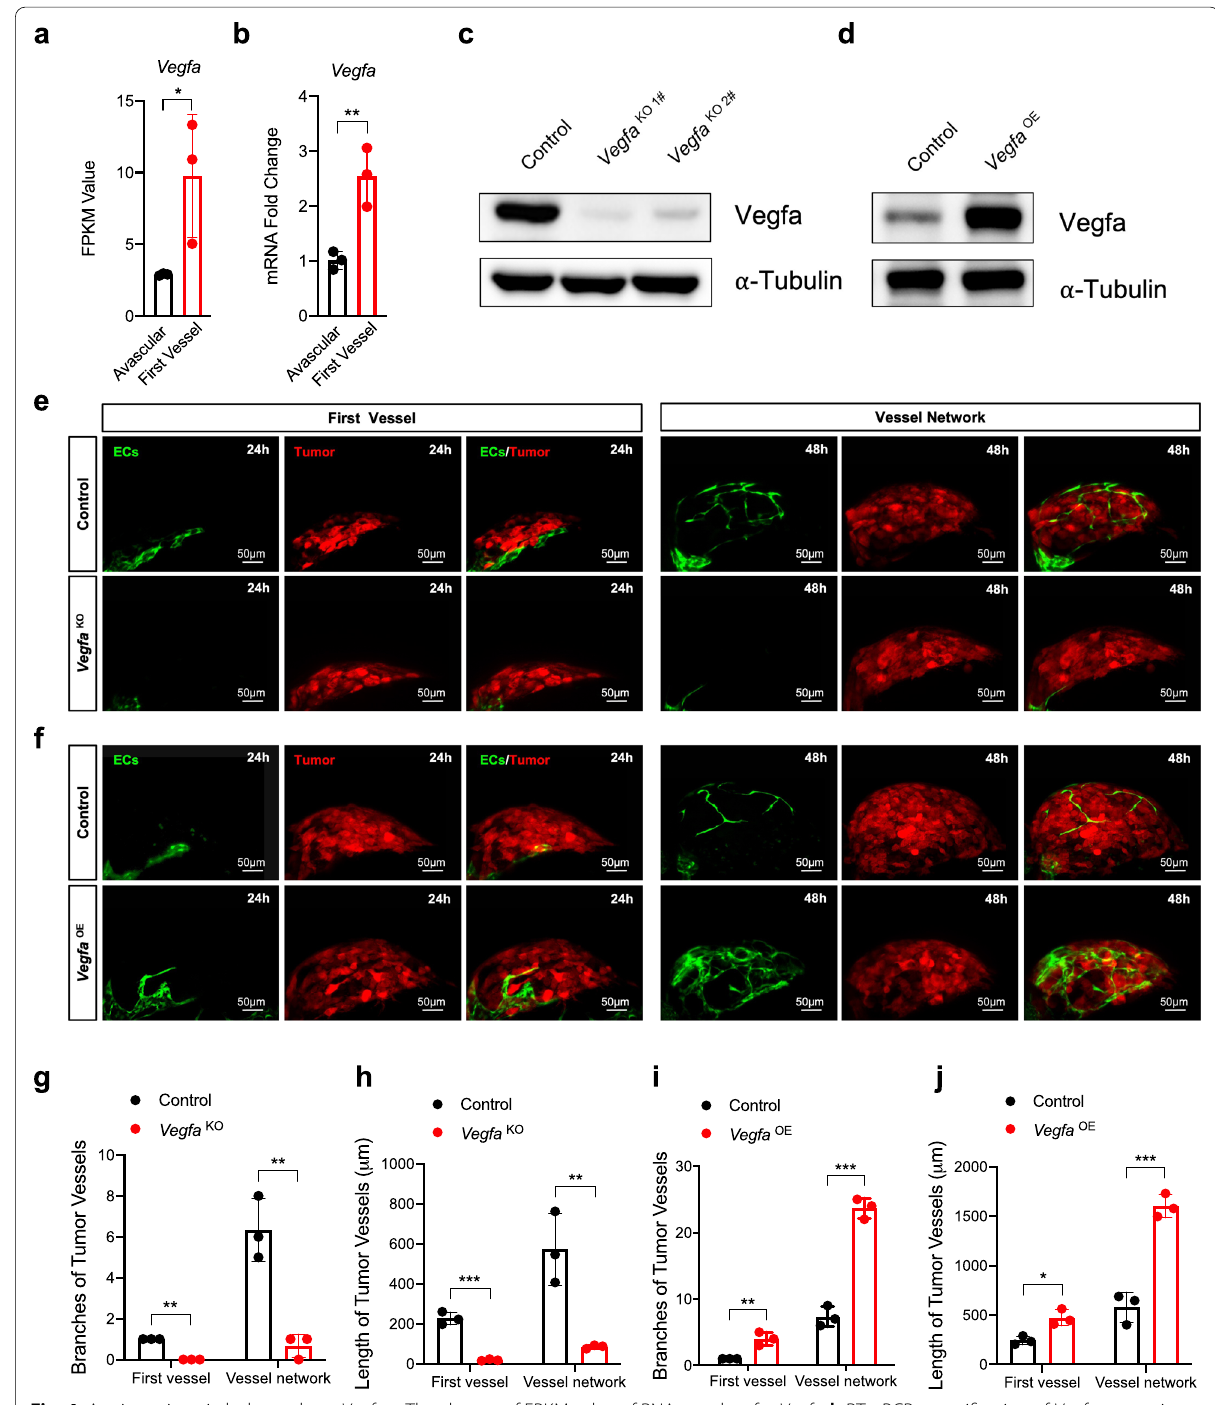
Fig. 4 Angiogenic switch depends on Vegfa . a The change of FPKM value of RNA-seq data for Vegfa . b RT-qPCR quantification of Vegfa expression in the transplant microtumors during the angiogenic switch (about 12 h and 24 h). c and d Western blot analysis of Vegfa and α-tubulin of B16-Red cells transfected with LentiCRISPRv2- Vegfa , sg1# ( Vegfa KO 1# ) or sg2# ( Vegfa KO 1# ) knockout plasmid or pcDNA3.1-VEGFA overexpression plasmid ( Vegfa OE ) for 48 h. e and f Imaging of the transplant tumor vascular growth of Vegfa knockout or overexpression B16-Red microtumors. ECs are green. Tumor is red. Scale bar, 50 μm. g‑j The branches and length of the first vessel and vessel network. Unpaired t-test, * P < 0.05, ** P < 0.01, *** P < 0.001 ( n =